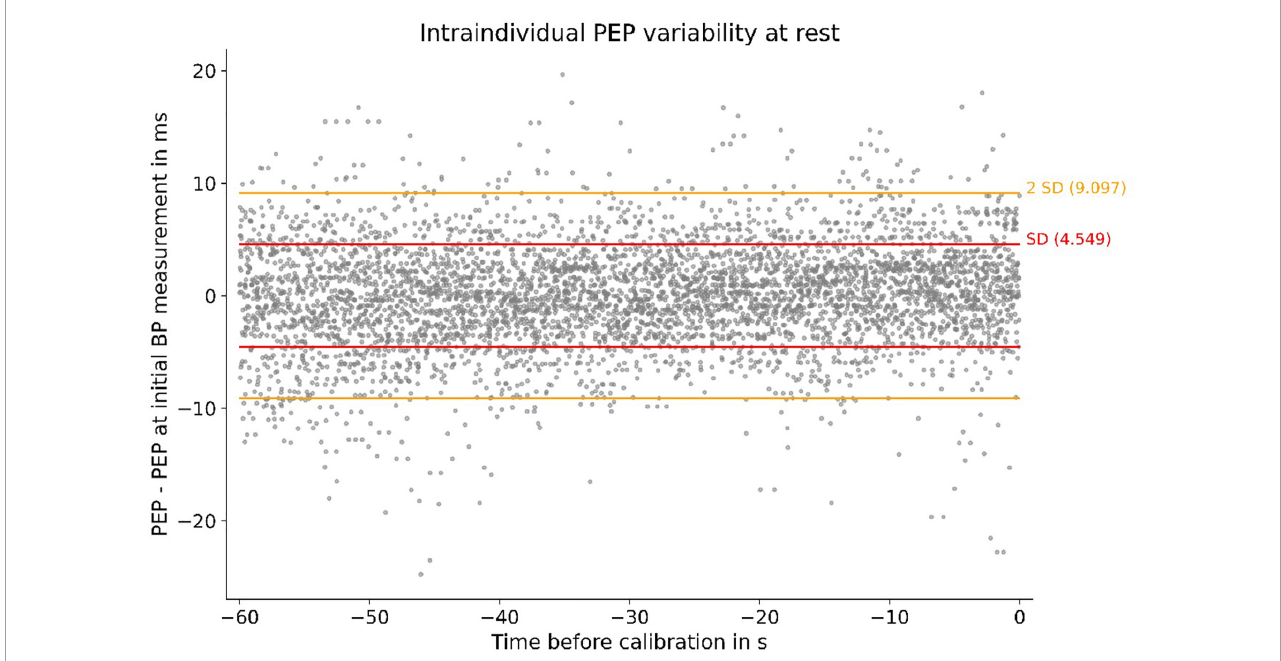
FIGURE3 Individual PEP variability at rest of all subjects. Measurements were obtained in the 60 s before calibration: SD, standard deviation; PEP–PEP at first BP measurement (at rest) depicted for 60 s before the BP measurement. The SD of 4.5 ms symbolizes small intraindividual PEP variability at rest.